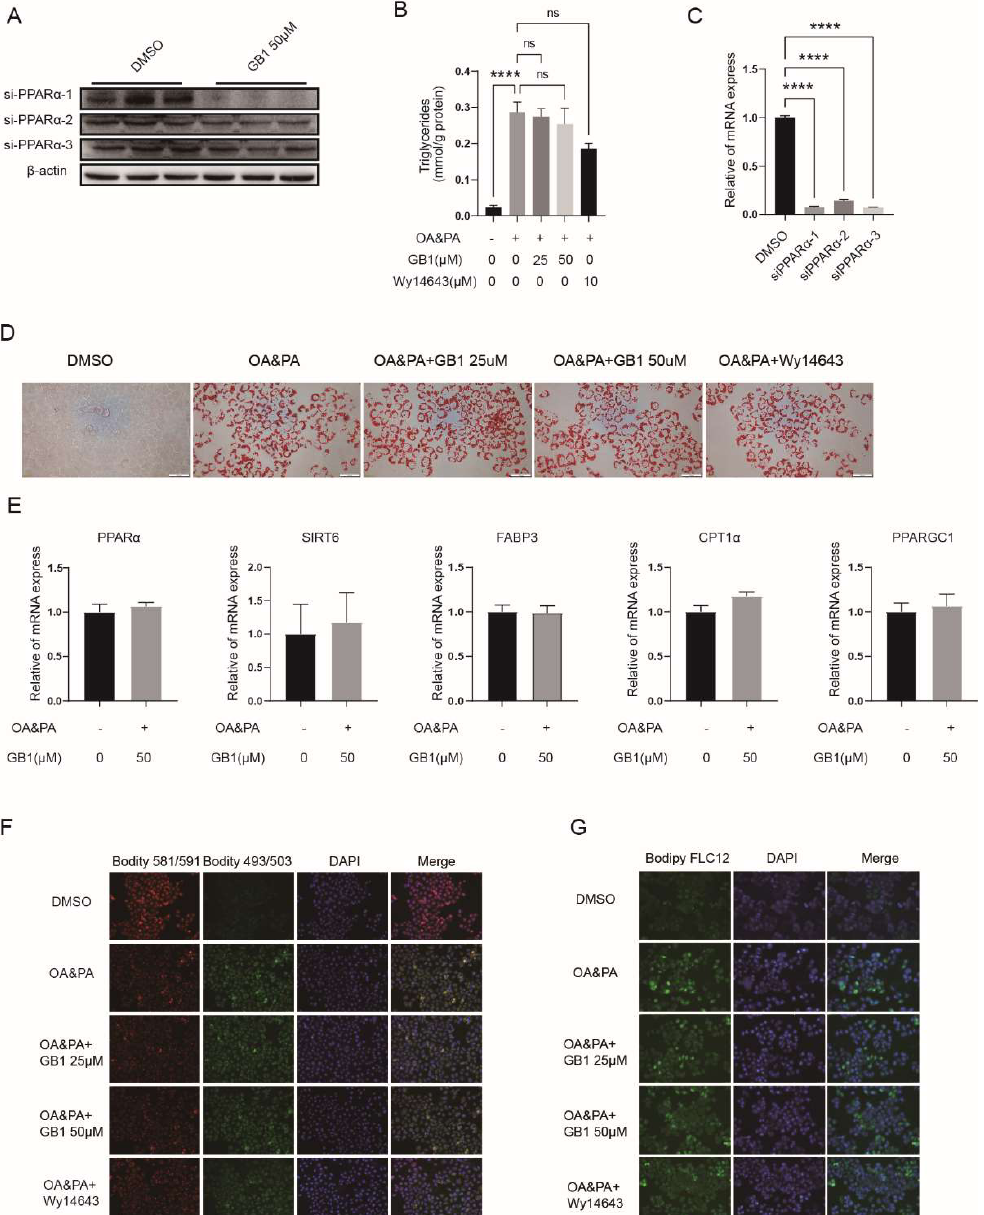
Figure 5. GB1 fails to improve the lipid deposition in PPAR α -deficient cells. PPAR α silenced by siRNA as demonstrated by Western blot ( A ) and RT-qPCR ( C ). ( B ) Level of triglycerides (TGs) in PPAR α -deficient cells after treatment with GB1. ( D ) Representative image of lipid deposition in PPAR α -deficient cells after treatment with GB1. ( E ) Levels of relevant genes in PPAR α -deficient cells after treatment with GB1. No significant alterations in the levels of lipid oxidization ( F ) and free fatty acids ( G ) in PPAR α -deficient cells after GB1 treatment under an inverted fluorescence microscope. All data were presented as mean ± SEM of three independent experiments. ****, p < 0.001; ns, not